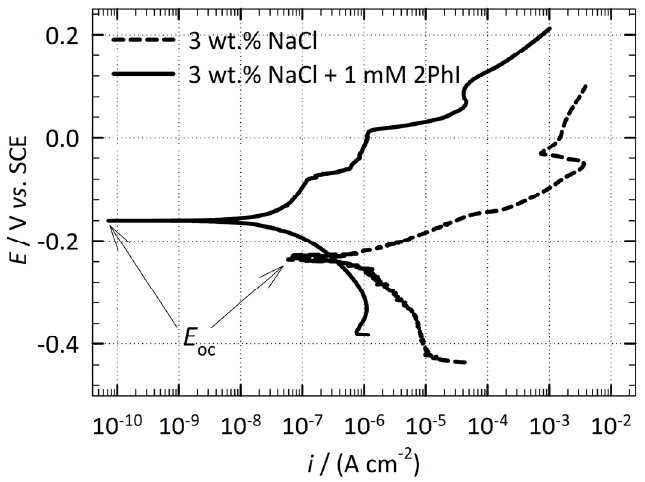
Figure 8. Potentiodynamic curve of the copper samples after 100 h of immersion in noninhibited [11] and 2PhI ‐ inhibited 3 wt.% NaCl solutions.